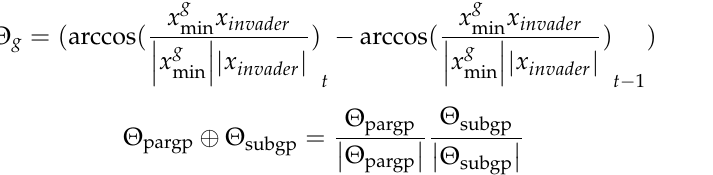
Algorithm 2 Sub-Swarm Trapping Algorithm